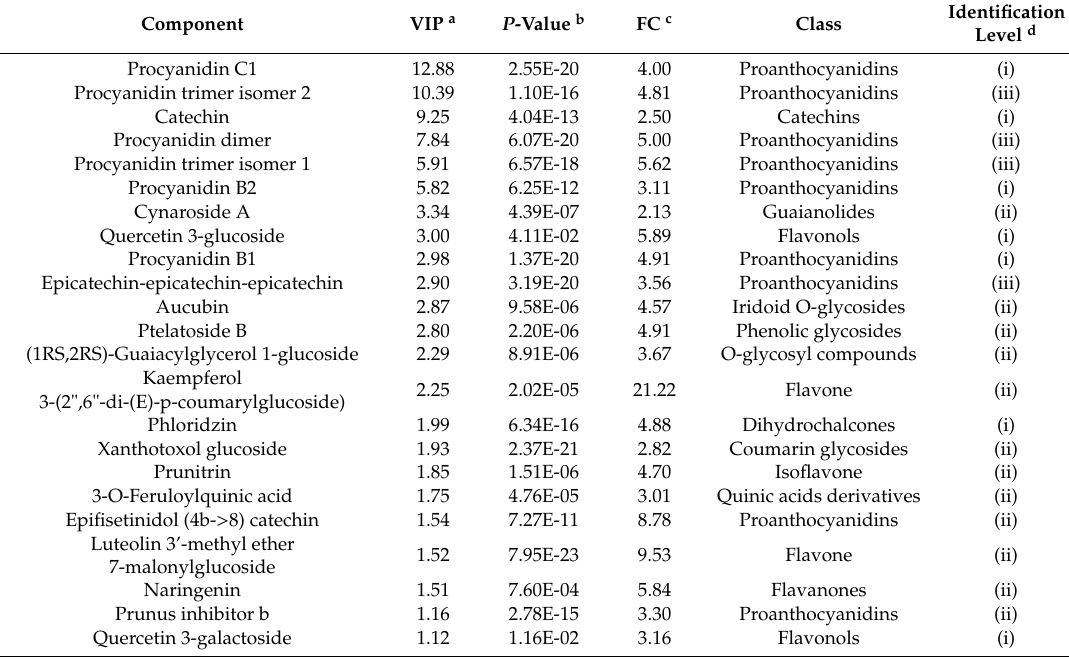
Table 3. Di ff erential characteristic components in peach pulp di ff erentiating the high (A, IC 50 < 15, 8 cultivars) and low (C, IC 50 ≥ 25, 6 cultivars) alpha-glucosidase inhibitory